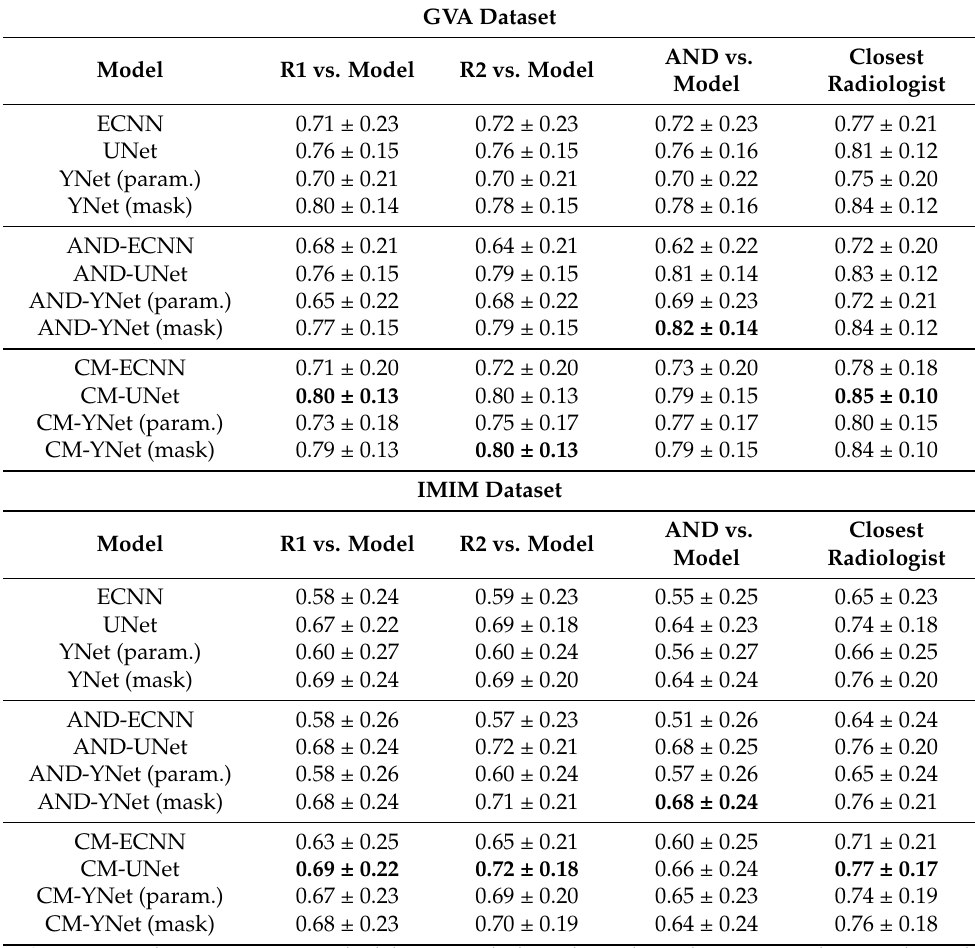
Table 2. Comparison of different models for the GVA (844 samples) and IMIM (381) datasets. Model R1 vs. Model R2 vs. Model